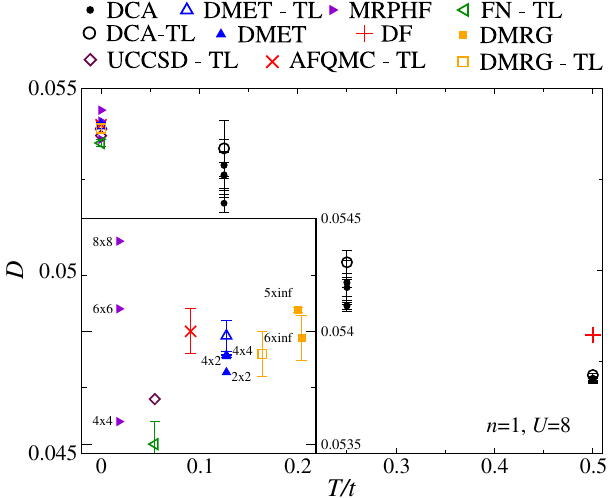
FIG. 5. Double occupancy data for U=t ¼ 8 and n ¼ 1 . Main panel: Temperature dependence of double occupancy, obtained from DCA (finite T , black circles) and DF (finite T , red plus sign), and the T ¼ 0 techniques AFQMC (red crosses), DMET (blue triangles), UCCSD (maroon diamonds), MRPHF (purple triangles), DMRG (orange squares), and FN (green triangles). Solid symbols represent finite systems; open symbols represent extrapolations to the thermodynamic limit. Inset: Data at T ¼ 0 reproduced with an arbitrary x -axis offset, from MRPHF, UCCSD, FN, DMET, DMRG, and